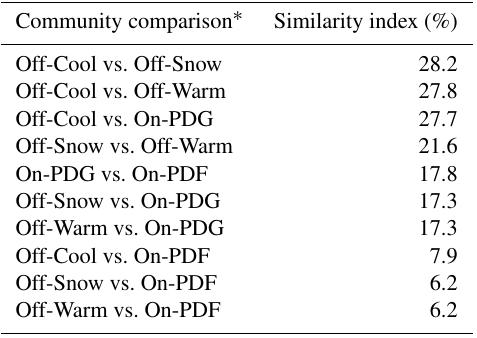
Table 2. Similarity index (Sørensen (Bray–Curtis) distance method) values averaged by plot across plant